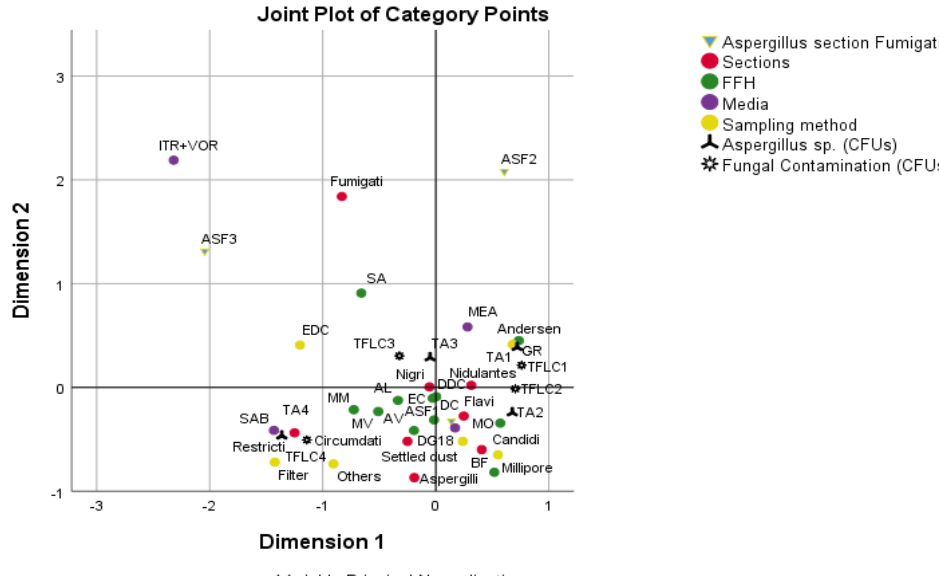
Figure 6. Results of multiple correspondence analysis. Study of the association between Aspergillus section Fumigati , sections, FFHs, media, sampling method, Aspergillus sp. and fungal contamination.